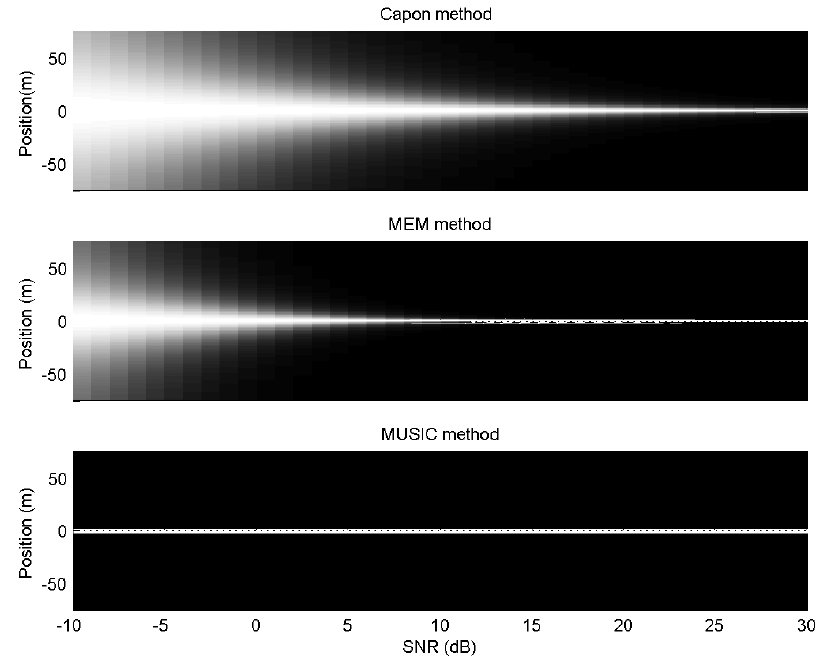
Fig. A2. Results of simulations for the Capon method (top), MEM (center) and MUSIC algorithm (bottom), assuming a single “infinitely” thin layer and for SNR from –10dB to